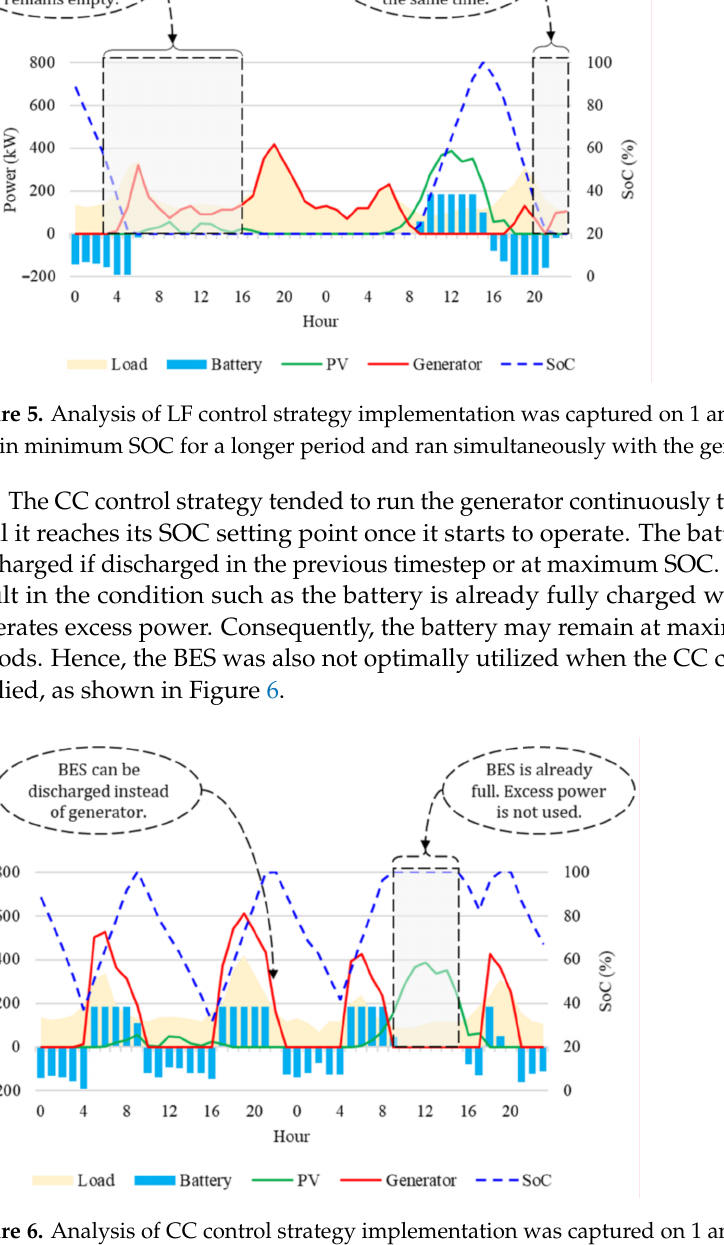
Figure 6. Analysis of CC control strategy implementation was captured on 1 and 2 January. The BES might not be discharged since it had not reached the SOC setpoint, and some excess power from the PV system could not be